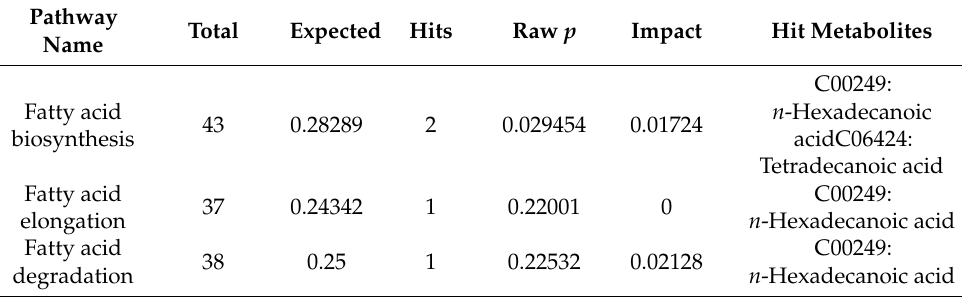
Table 3. The key metabolic pathways of differential metabolites in B. dorsalis larvae.